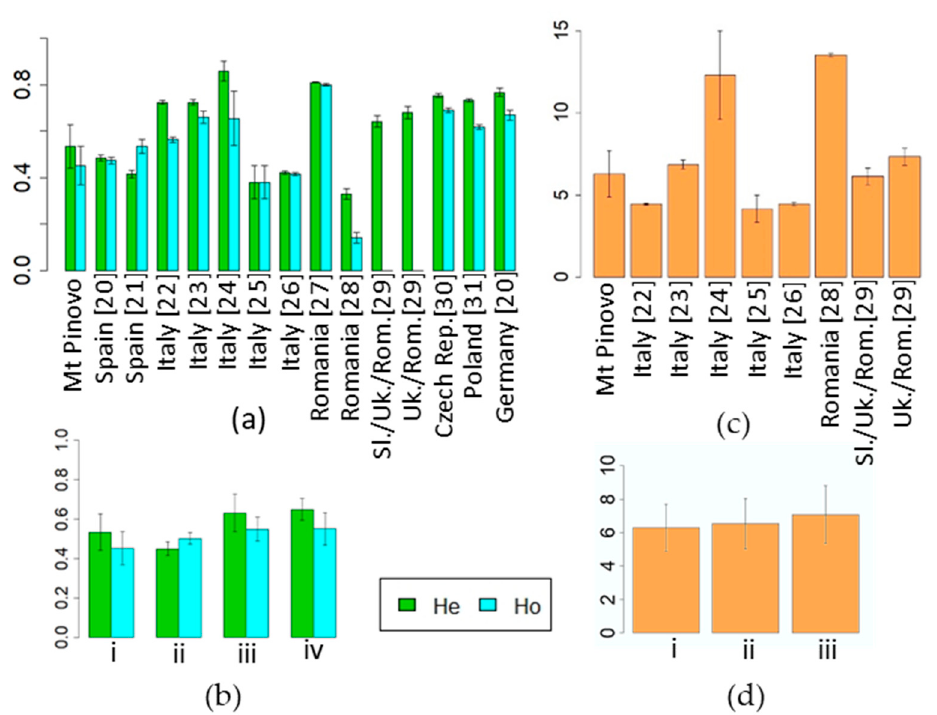
Figure 2. Comparing: ( a , b ) Observed and Expected Heterozygosity and ( c , d ) Allelic Richness of Mt. Pinovo with populations from SW, S part of the region and the main region of Abies alba distribution. Ho from Slovakia (Sl.), Ukraine (Uk.) and Romania (Rom.) were not available. No AR was listed for populations from Spain. i: Mt Pinovo, ii: Spain [20,21], iii: Italy [22–26], iv: Main range [22,26–31]. Numbers in brackets are the references used.